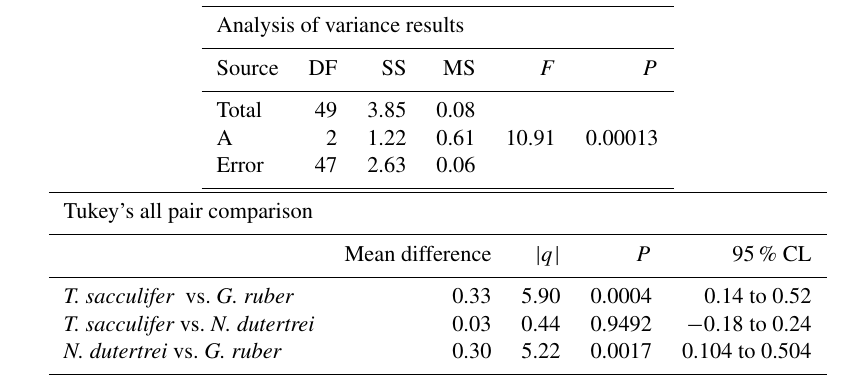
Table 3. Results of the ANOVA test comparing the means of the three different species corrected for vital effect: T. sacculifer , G. ruber and N. dutertrei .